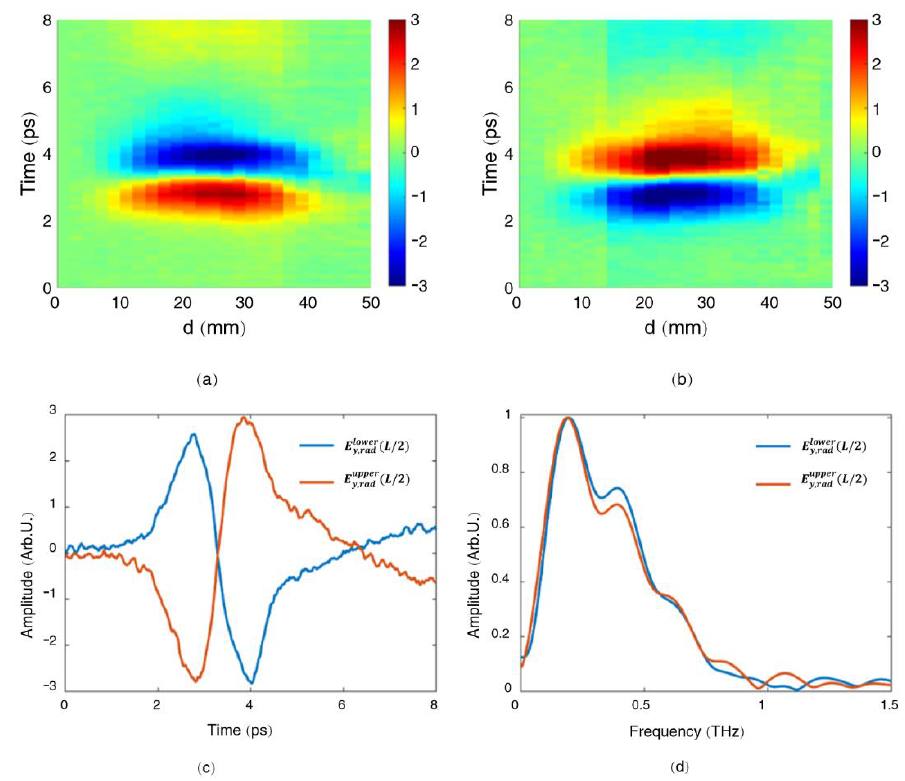
Figure 6. Vertical components of the radially polarized THz beam when scanning the mask upwards ( d ) ) ( a ), and downwards ( E upper ( d ) ) ( b ); ( c , d ) are, respectively, the waveforms and the wards ( E lower ( 𝐸 𝑦,𝑟𝑎𝑑𝑙𝑜𝑤𝑒𝑟 (𝑑) ) ( a ), and downwards ( 𝐸 𝑦,𝑟𝑎𝑑𝑢𝑝𝑝𝑒𝑟 (𝑑) ) ( b ); ( c , d ) are, respectively, the waveforms and the cor- y , rad y , rad ( L /2 ) and E upper ( L /2 ) responding spectra of 𝐸 𝑦,𝑟𝑎𝑑𝑙𝑜𝑤𝑒𝑟 (𝐿/2) and 𝐸 𝑦,𝑟𝑎𝑑𝑢𝑝𝑝𝑒𝑟 (𝐿/2) . corresponding spectra of E lower y , rad y , rad